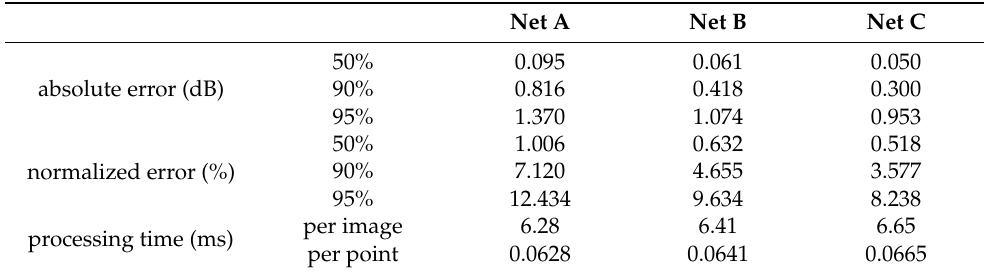
Table 2. CNN performance of diffraction loss prediction.